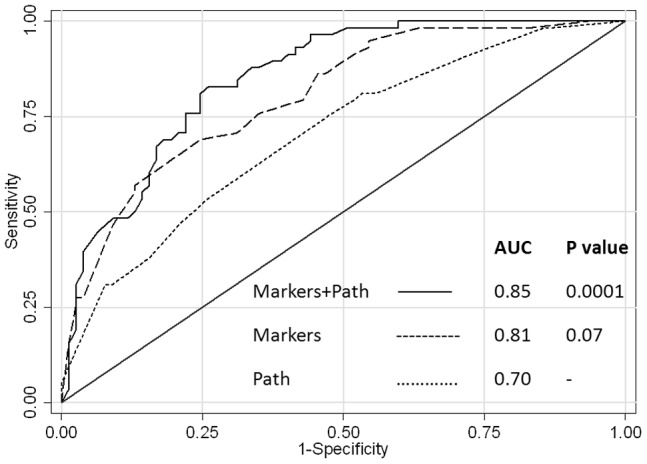
ROC curves of 3 predictive models of survival for the study cohort: Protein biomarkers and conventional pathologic features (——, MUC1, MUC2, MSLN, lymph node status, resection margin status, tumor differentiation); protein biomarkers only (------, MUC1, MUC2, MSLN); conventional pathologic features only (……, lymph node status, resection margin status, tumor differentiation, size).Values along the indicated diagonal line (line of no-discrimination) reflect a random guess, with points above the line being better than random. Harrel’s C-index or area under the curve (AUC) for each plot is provided. P values refer to comparisons between the given ROC curve as compared to pathologic features only.